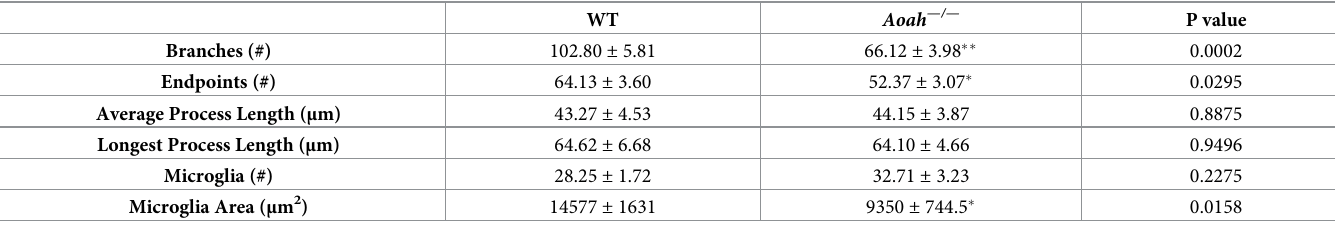
Table 1. Microglia skeletal analyses in paraventricular